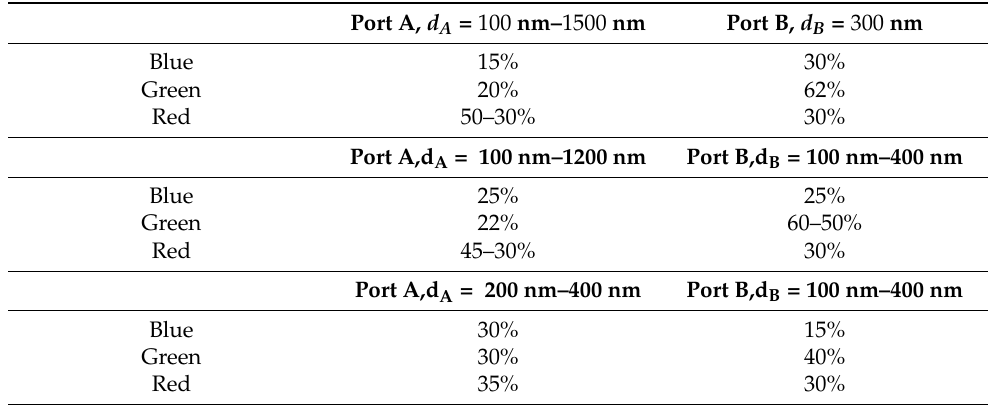
Table 2. Total transmittance measured for three different RGB colors at inclined